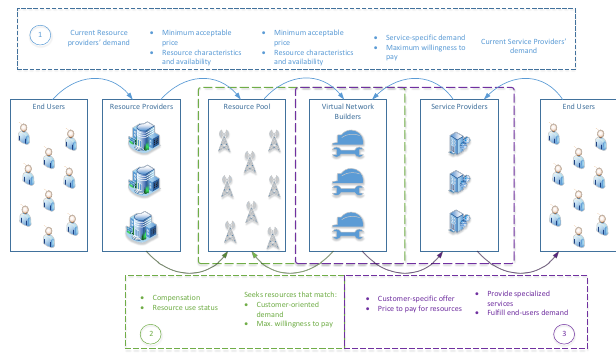
Figure 5. Interactions among network participants for obtaining resource